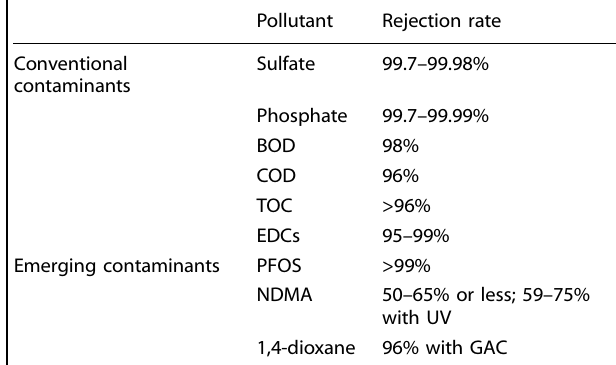
Table 9. Rejection rates of various pollutants by RO membranes 191,192